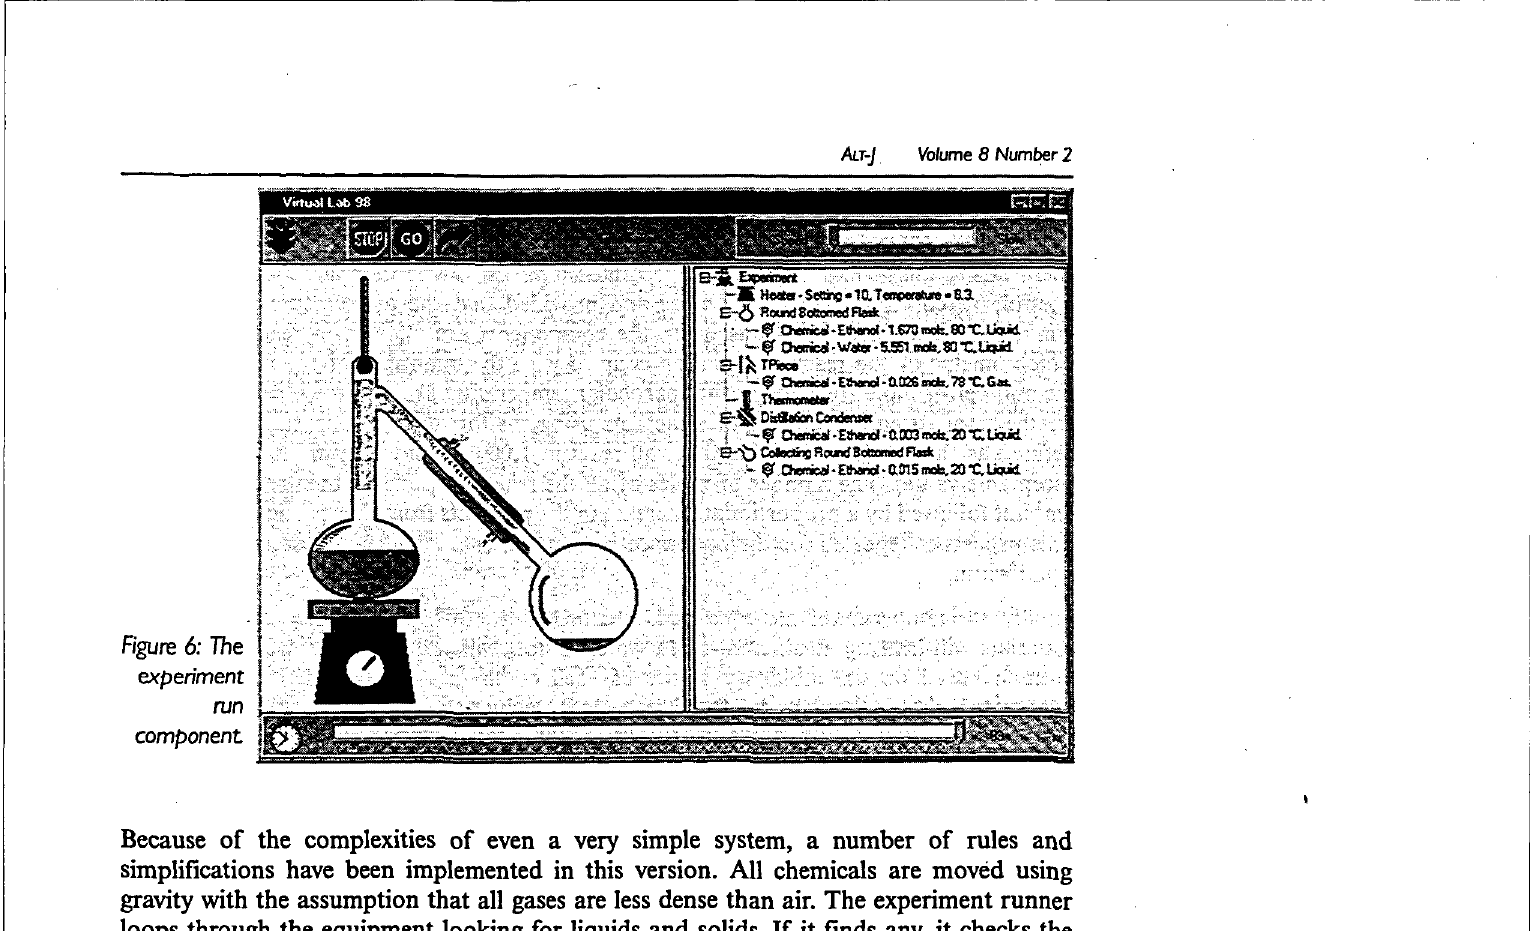
figure 6: The experiment run